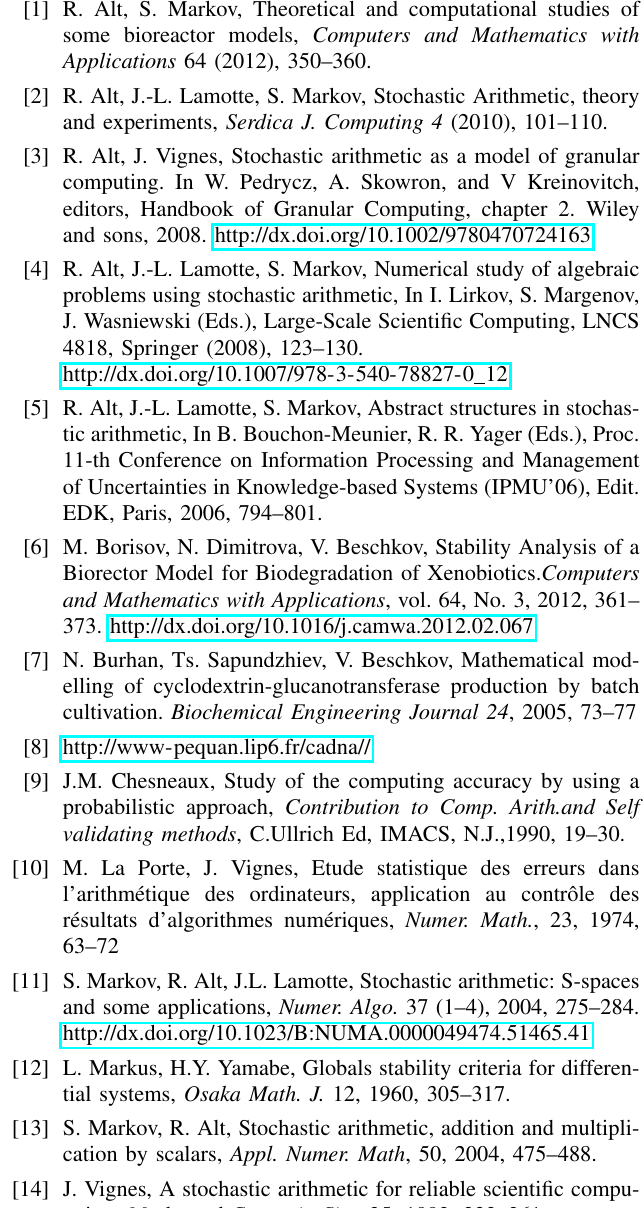
Fig. 9: Sensitivity of (8) to 100% errors on initial